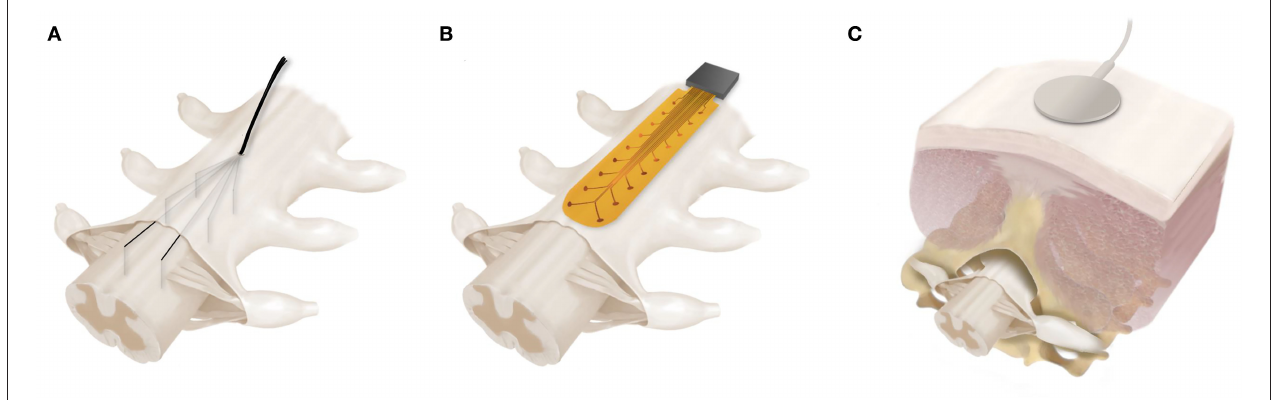
FIGURE 4 | Spinal cord electrical stimulation. Different approaches have been developed in the last years to neuromodulate the spinal cord. (A) Intraspinal electrodes within the spinal gray matter, close to the motoneuron pools; (B) Epidural electrode arrays are placed over the dorsal side of the spinal cord fixed to the outer side of the meningeal layer; (C) Transcutaneous stimulation is delivered by big size adhesive electrodes which are placed percutaneously on the back